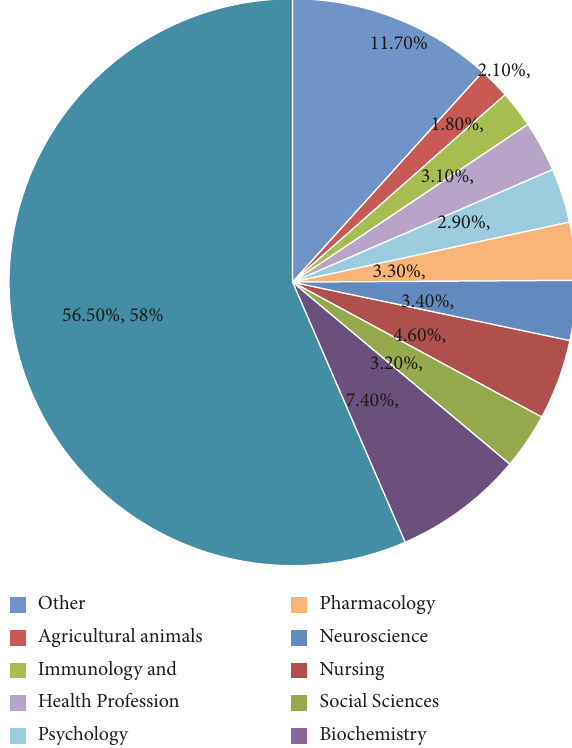
Figure 8: Pie chart depicting article distribution by disciplines for systematic review